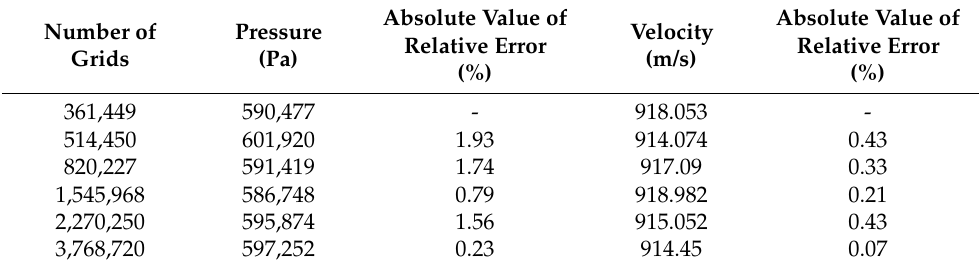
Figure 1. Structural diagram of the steam ejector. Table 2. Verification of grid independence of nozzle outlet section center.